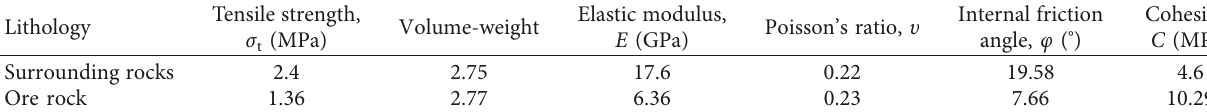
Table 2: Mechanical parameters of the model.